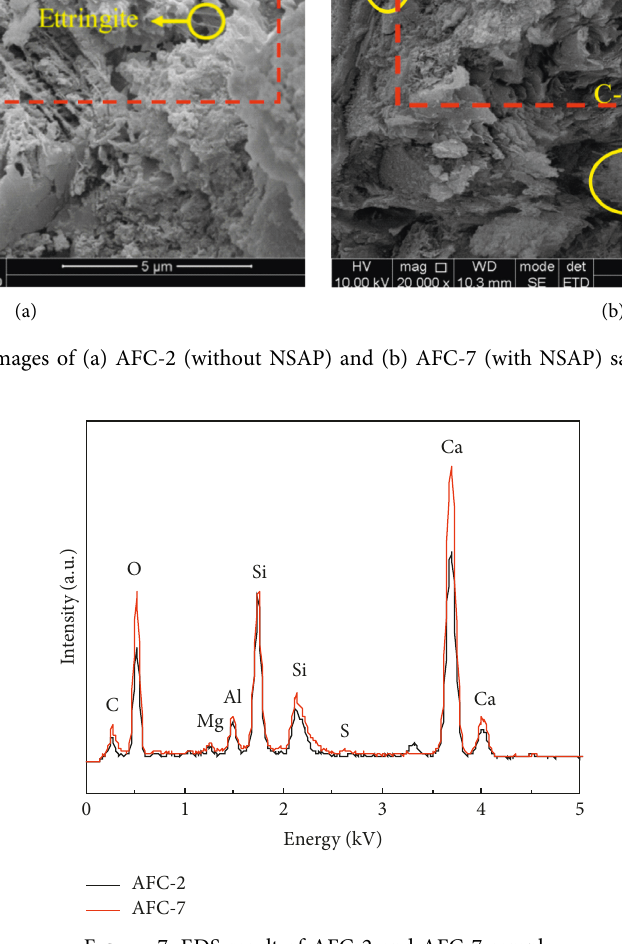
Figure 7: EDS result of AFC-2 and AFC-7 sample.